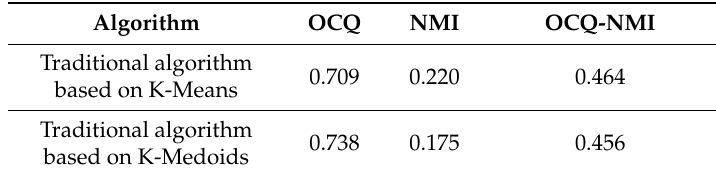
Table 2. Comparison of clustering e ff ects of traditional clustering construction algorithm based on K-Means and